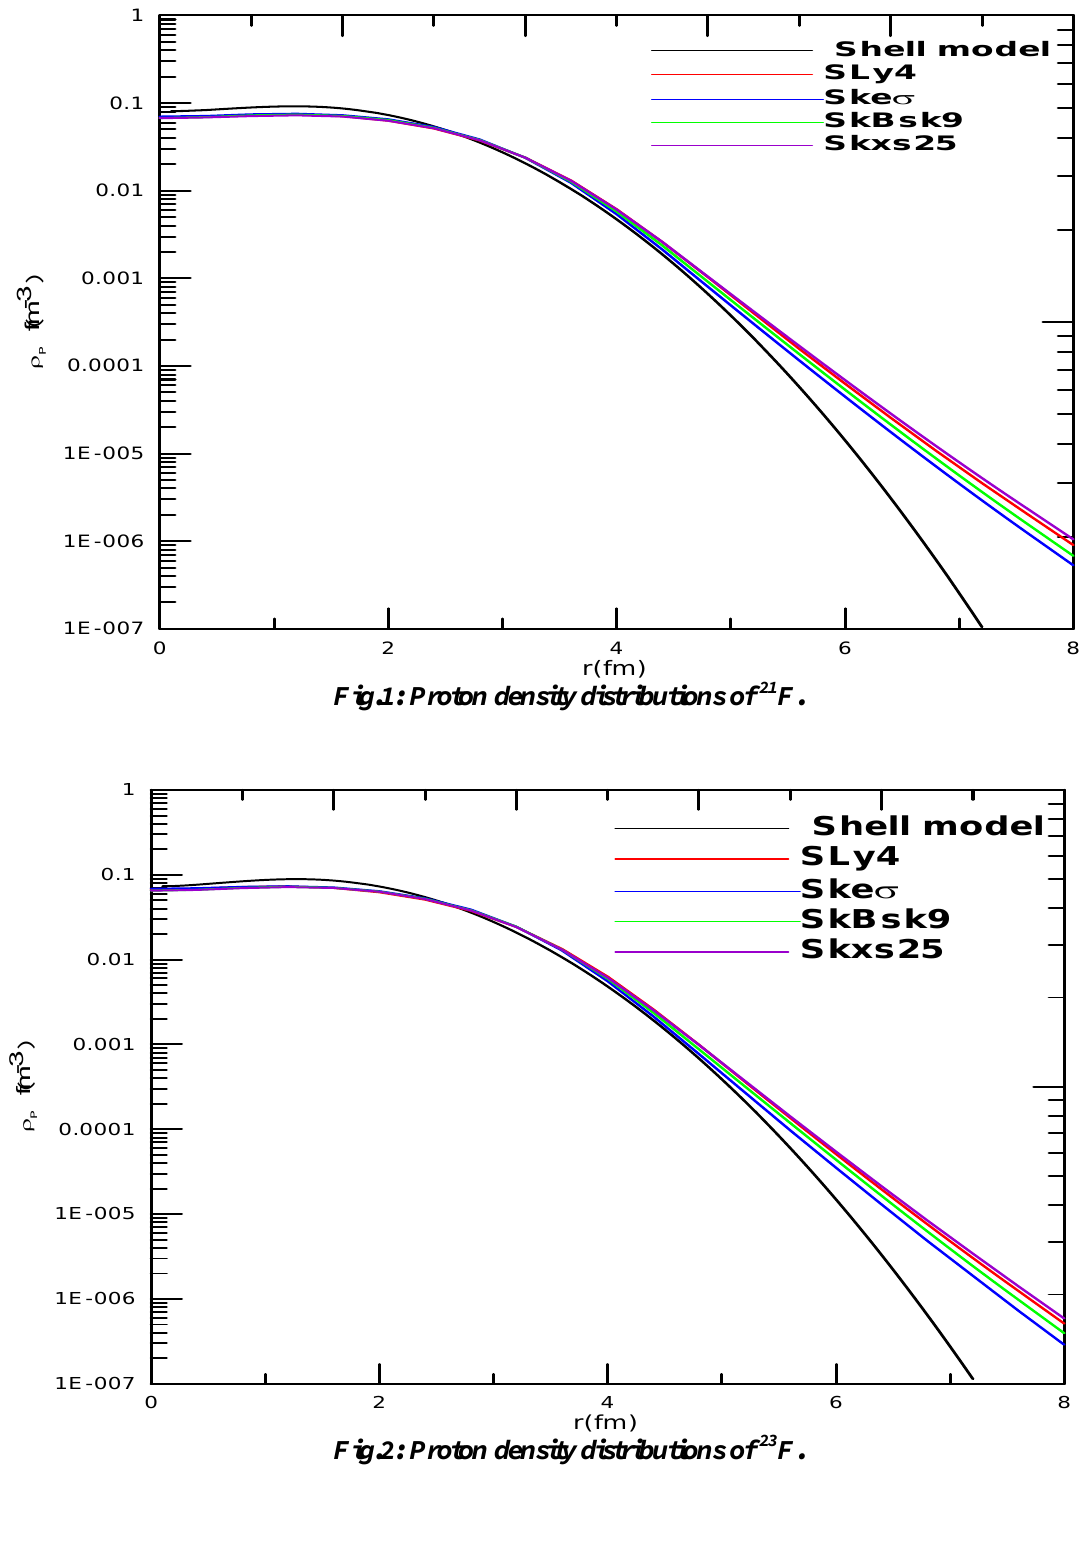
Fig.2: Proton density distributions of 23